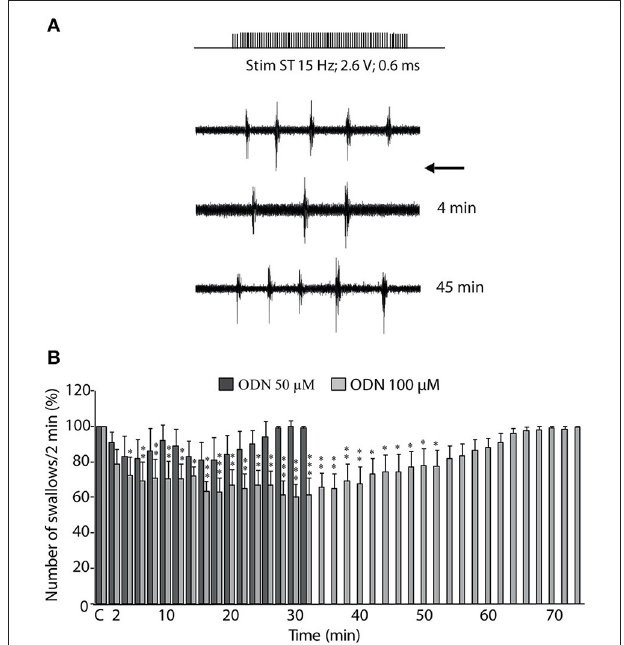
FIGURE 8 | ODN inhibition of swallowing reflex. (A) Effects of ODN on sublingual muscle electromyographical activity induced by solitary tract (ST) stimulation. ODN (100 µ M, arrow) injected within the swallowing pattern generator (SwCPG) induced a powerful inhibition of the number of swallows. Note that this inhibitory effect intervened rapidly after ODN application ∼ 4 min. This effect was transient since the swallows recovered after 45 min. (B) Time course of the effects of ODN doses injected within the SwCPG at 50 µ M (dark bars, 5 trials) and 100 µ M (gray bars, 10 trials) on the number of swallows recorded over 2-min periods and until recovery. “C” represents the mean value of the control recorded before ODN microinjection (100%). Data are represented as means ± SEM normalized to the control value. * P < 0.05, ** P < 0.01, *** P < 0.001 significantly different from control. with glial and ependymal cells (Alho et al., 1989).